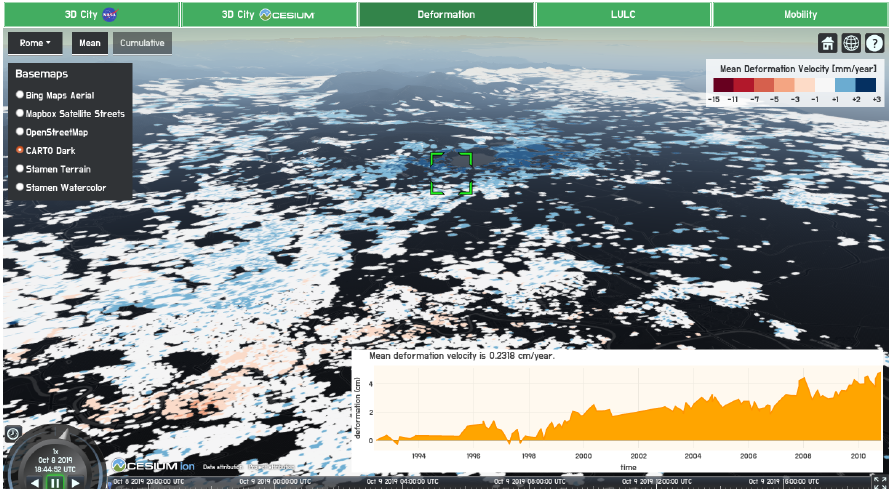
Figure 7. Visualization of mean deformation velocity map of Rome and plot of cumulative deformation time series of a deformation point on a virtual globe created using